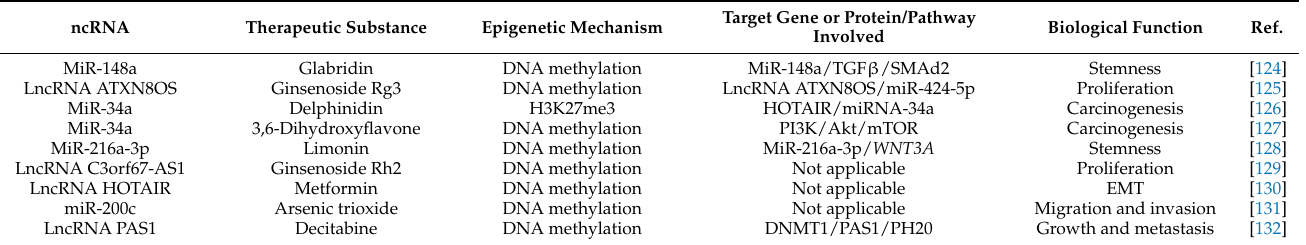
Table 4. Treatment strategies based on methylation of